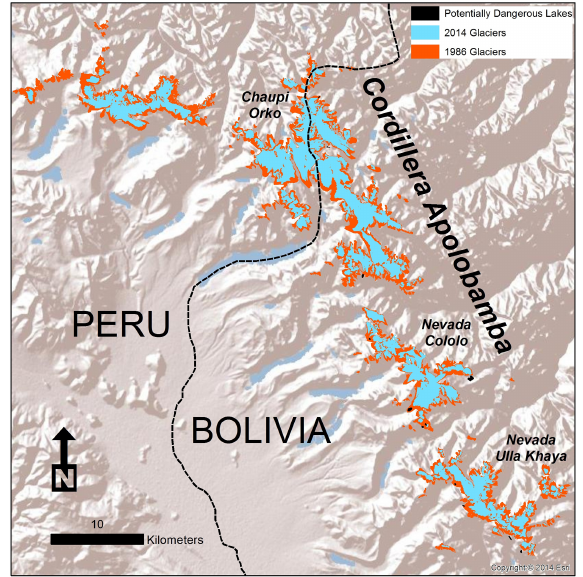
Figure 5. Glacier change 1986–2014 for the Cordillera Real. Map (a) shows the main (northern) part of the Cordillera Real, and map (b) shows an inset of the southern Cordillera Real. See Fig. 1 for location of region. Base map is the Esri World Shaded Relief map